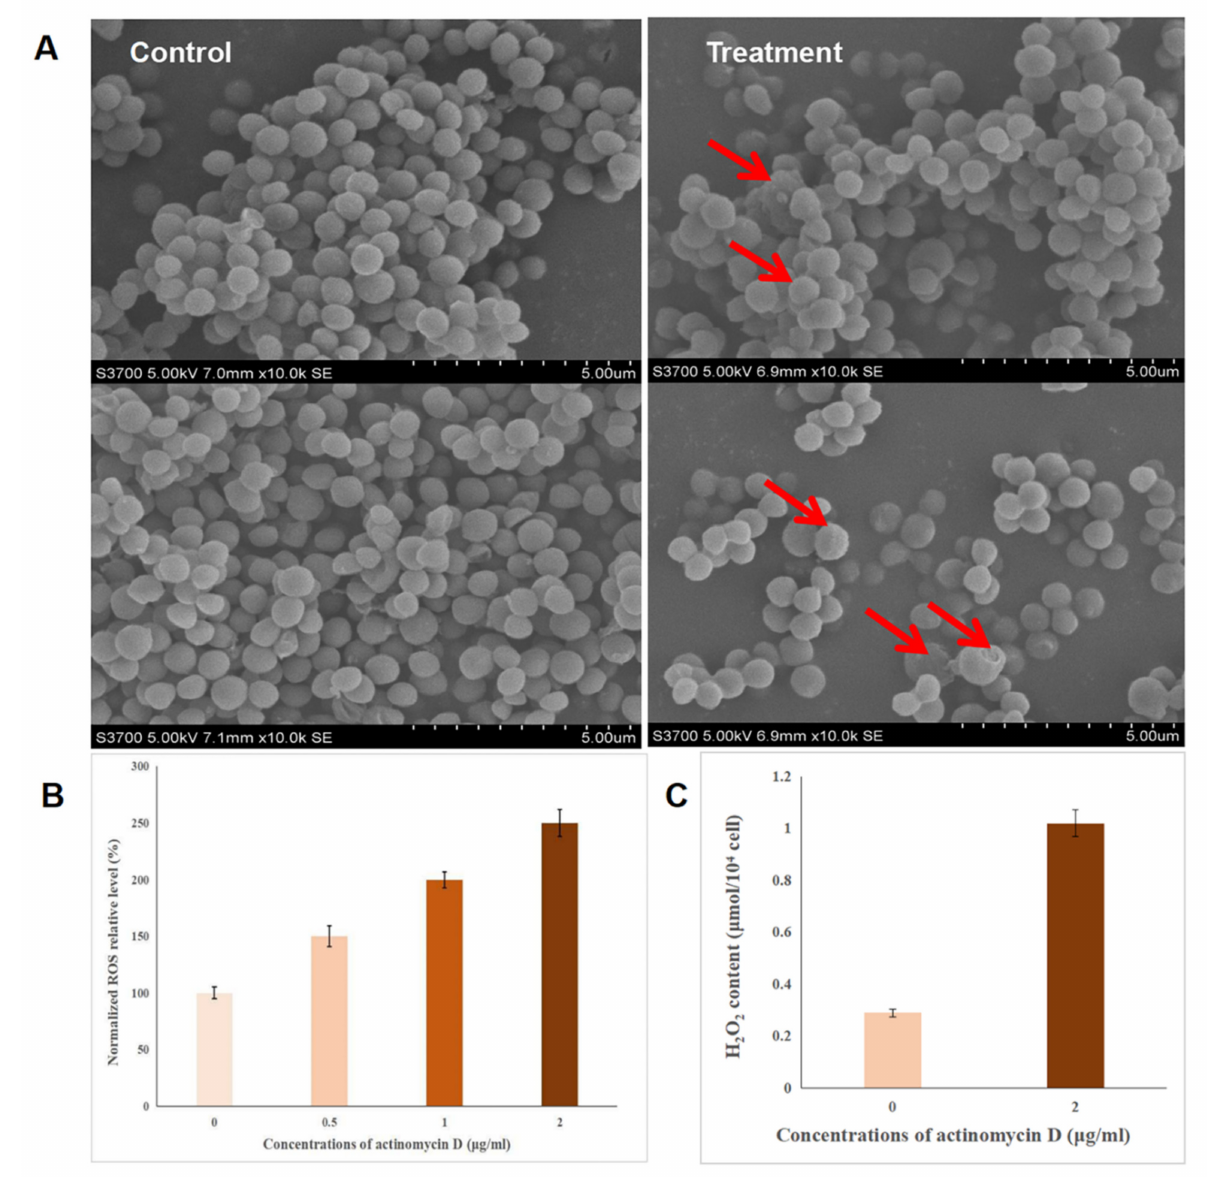
Figure 2. The effect of bacterial morphology and index factors. ( A ) Bacterial morphology affected by actinomycin D in the control group and treatment group. ( B ) Intracellular relative ROS levels in actinomycin D; higher concentrations of actinomycin D with higher ROS relative levels. ( C ) Intracellular relative H 2 O 2 levels in actinomycin D; the content of H 2 O 2 in the treatment group (2 ug/mL) was 3.5 times more than the control